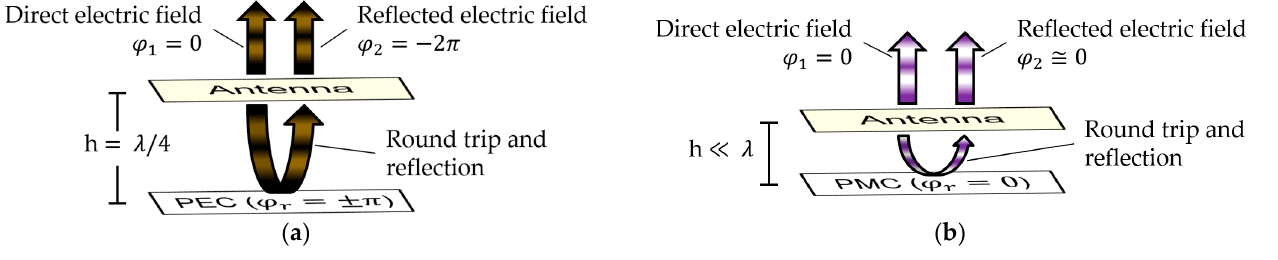
Figure 1. Optimization of gain in the broadside direction: ( a ) antenna distanced by ℎ = λ/4 from a PEC reflector; ( b ) antenna distanced by ℎ ≪ 𝜆 from a PMC reflector.